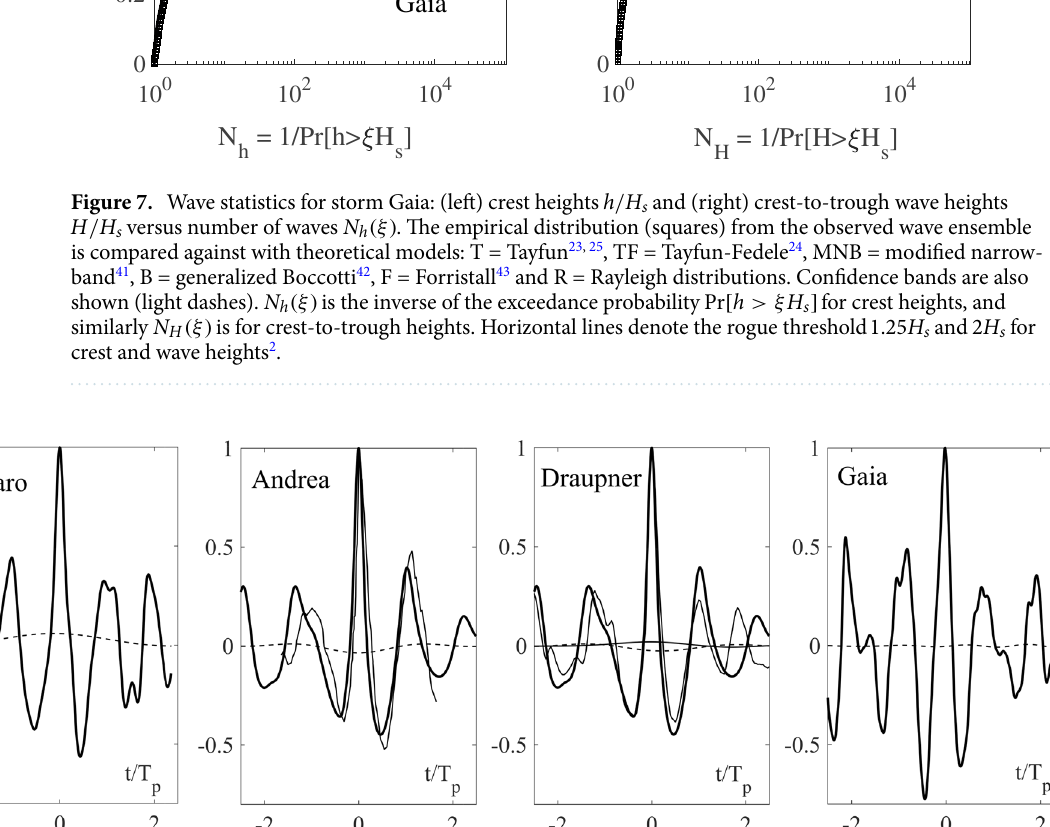
Figure 8. Simulated wave profiles η/η max (solid) and mean sea levels (MSL) (dashed) versus t / T p for (from left to right) El Faro, Andrea and Draupner sea states. Gaia largest wave observed is shown in the right panel. Actual measurements (thin solid) and MSLs (thin solid) are also shown for Draupner. Note that the Gaia MSL is insignificant and the Andrea MSL is not available. η max is the maximum crest height and T p is the dominant wave period (see Table 1 and “Methods” section for